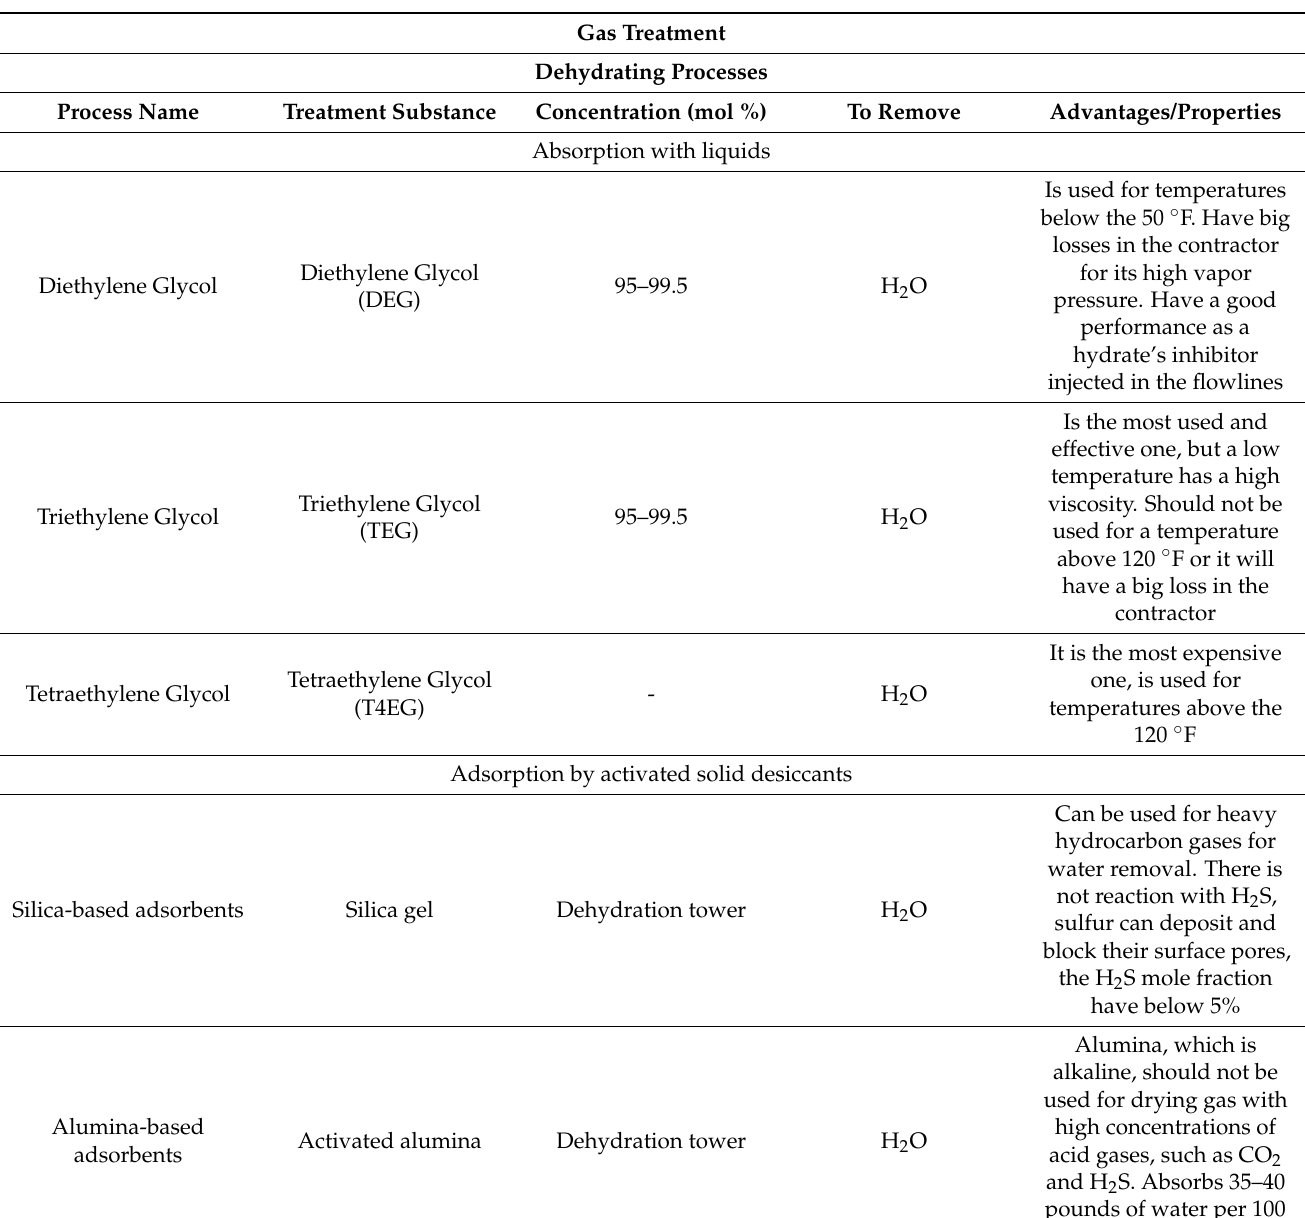
Table 4. Gas treatment dehydrating processes